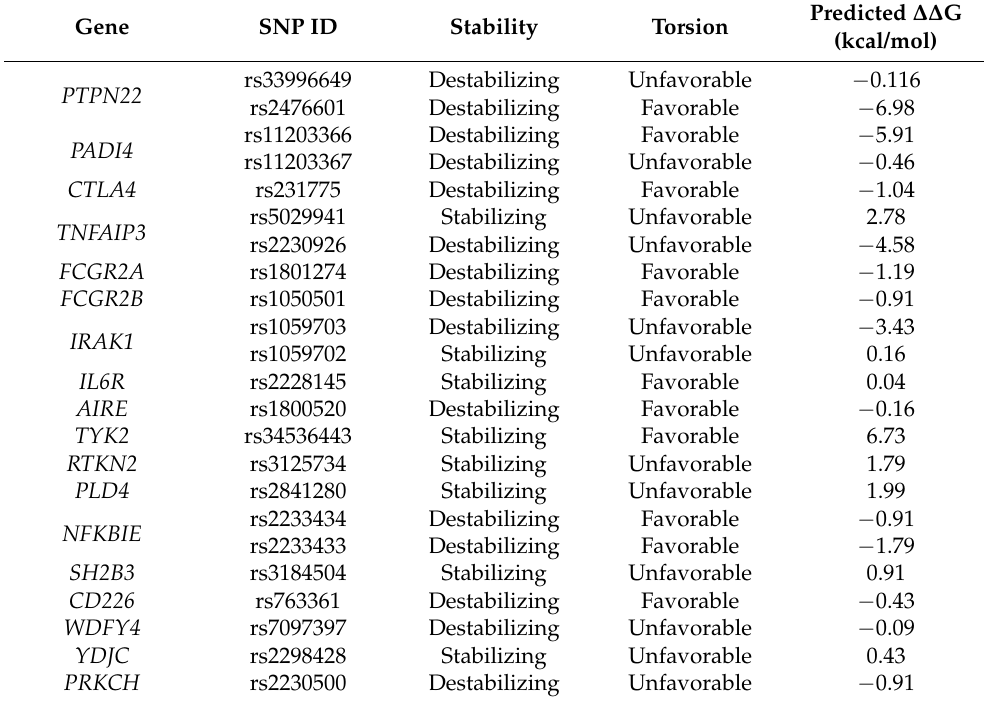
Table 4. Prediction of protein stability upon introduction of the nsSNP.